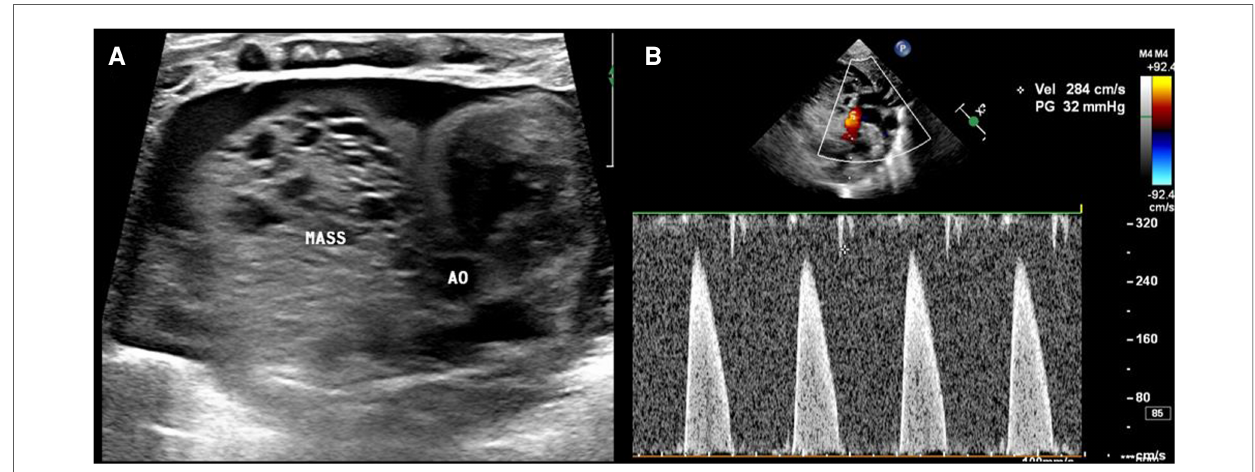
FIGURE 2 Postnatal ultrasound images. ( A ) The mass (MASS) is close to the ascending aorta (AO), and the boundary is not clear. ( B ) The mass compresses the ascending aorta, and the velocity in the ascending aorta reaches approximately 2.8